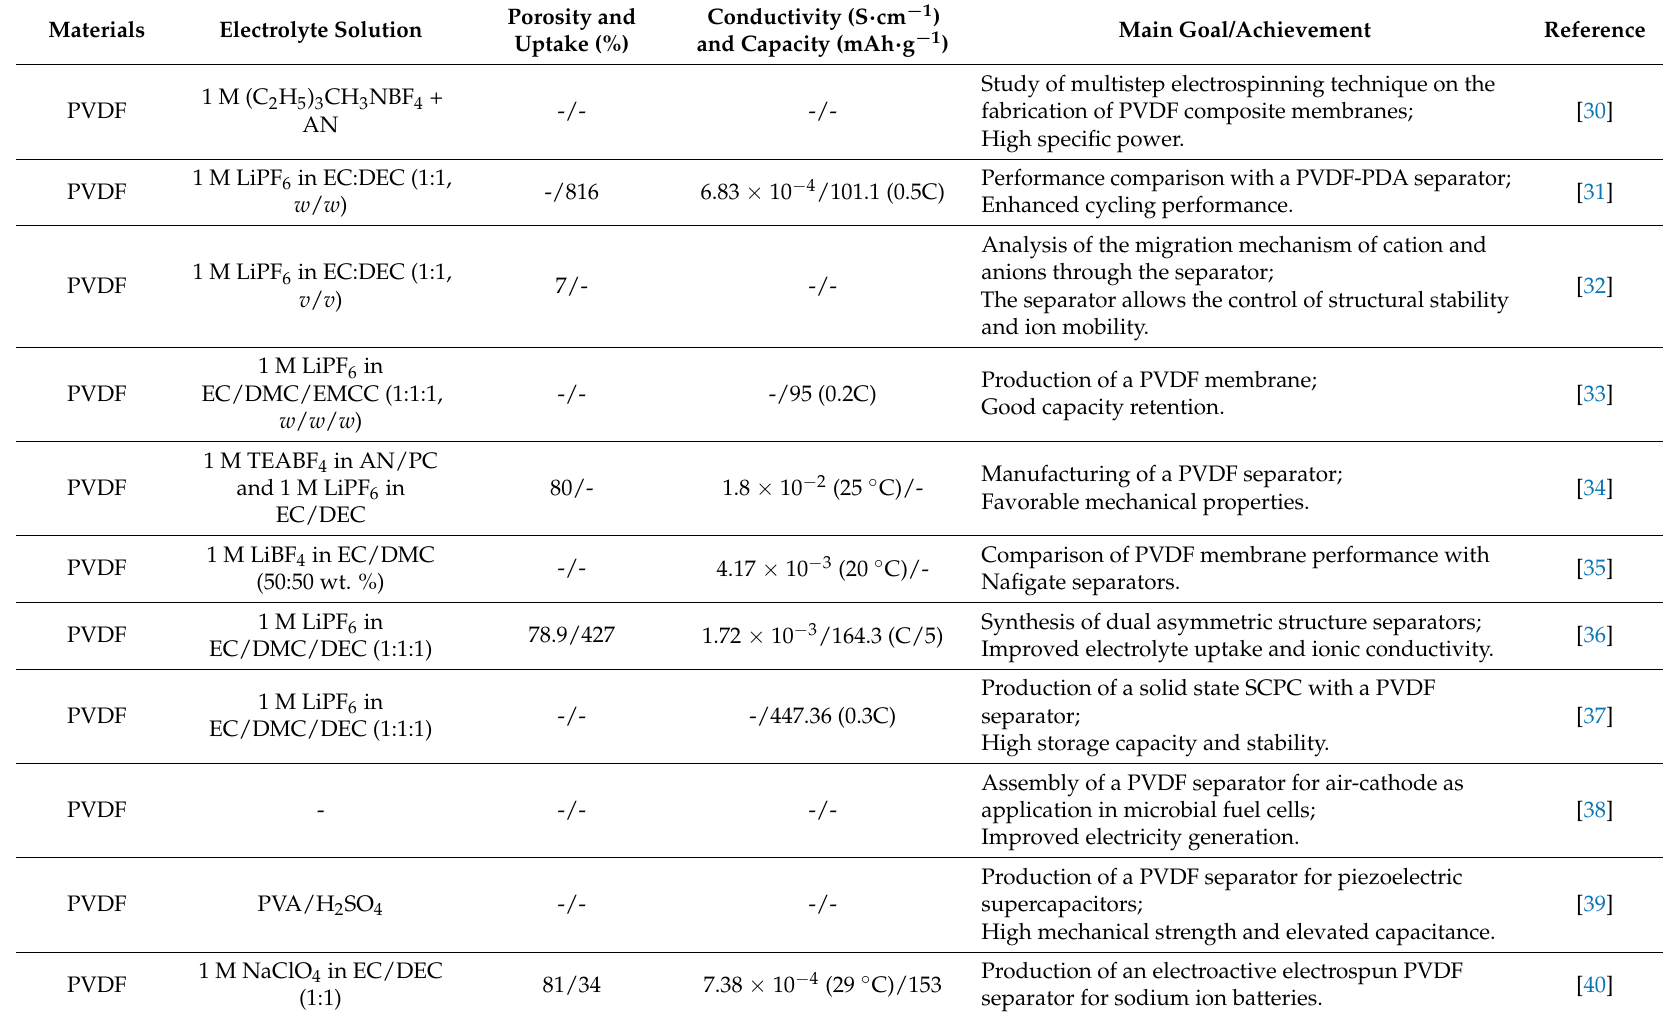
Table 3. Separator membranes based on PVDF and co-polymers, indicating also the main properties, and the main goal/achievement of the investigation.